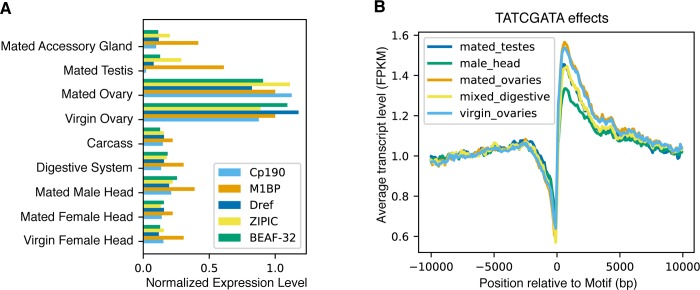
Identified maternal regulators are ovary-enriched, as is their effect on transcription.(A) RNA levels of putative binding proteins by tissue type. Transcript abundances within each gene have been normalized such that the average abundance in ovaries is equal to 1. While identified maternal regulators have regulatory functions in multiple tissue types, they are highly enriched in ovaries compared to other tissues. (B) Average normalized expression levels versus proximity to motif by tissue type. Normalization was performed by dividing each expression value by the average expression from 9.9-10kb away. While binding sites for identified maternal regulators are present in multiple tissues, the effect on gene expression is stronger in ovaries compared to other tissues. All data used were from tissues sampled from four-day-old adults.